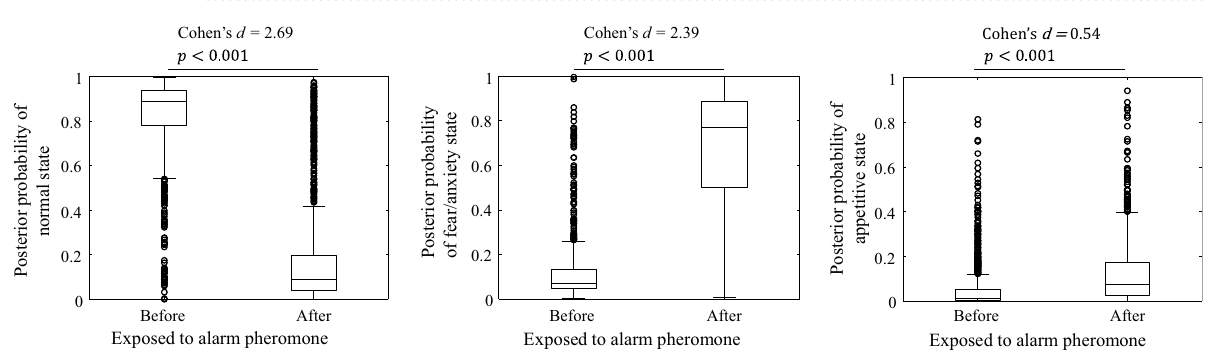
Figure 10. Posterior probability obtained from LLGMN in the alarm pheromone experiment. The plots compare the posterior probabilities of each emotional state between before and after exposure to the alarm